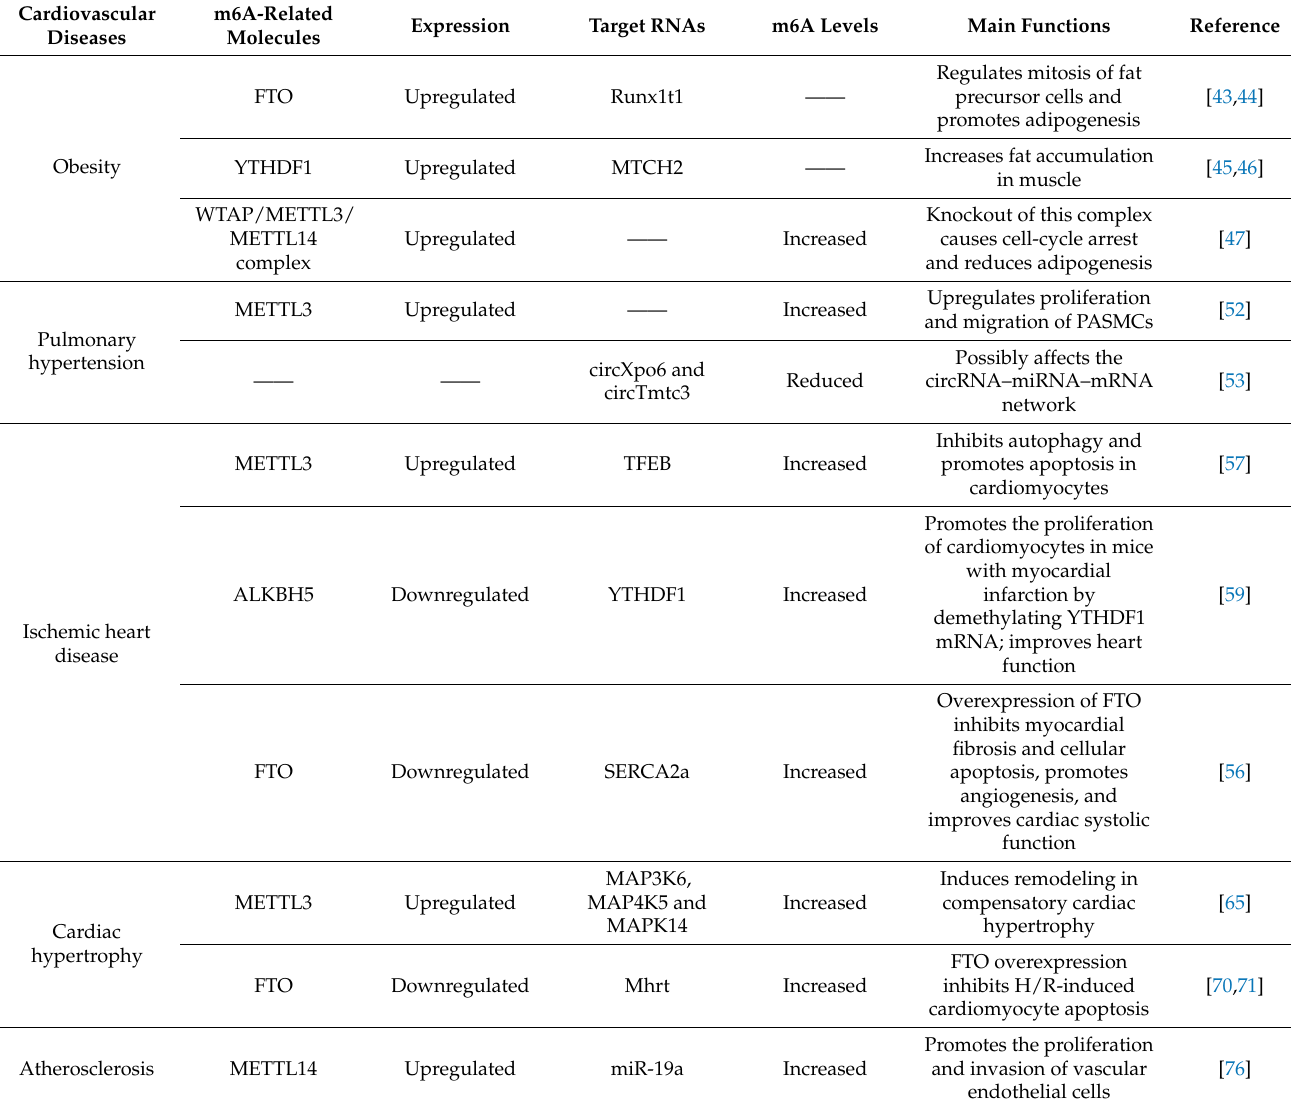
Table 1. The roles of m6A methylation in CMDs. ——: not